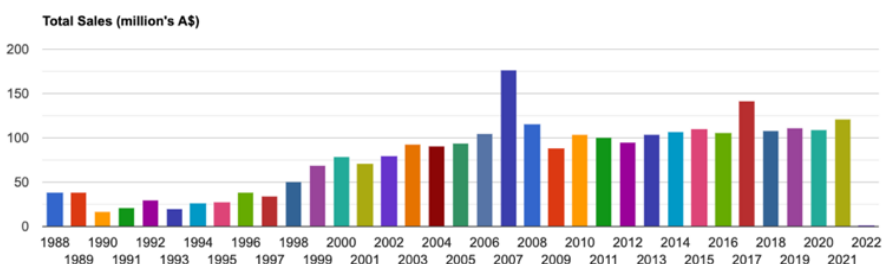
Figure 1. Annual Australian art auction sales. Source: John Furphy, Australian Art Sales Digest database, accessed on 18 February 2022. https://www-aasd-com-au.eu1.proxy.openathens.net/index.cfm/annual-auction-totals/.